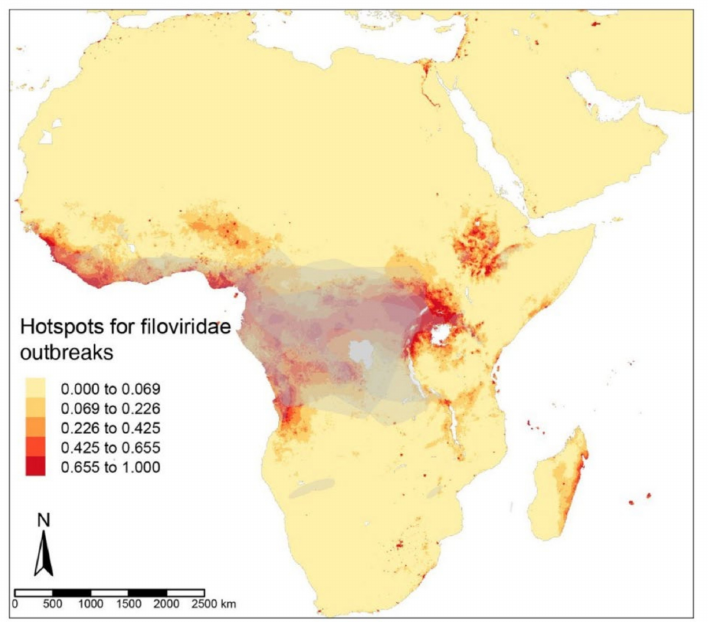
Figure 1. Predictive risks of Filoviridae disease emergence modeled from the ZIB iCAR model with a spatial distribution of the mammalian reservoirs in